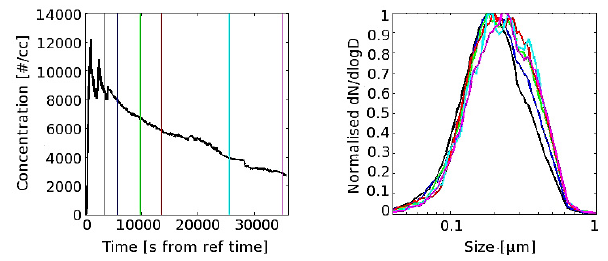
Table 1. ICIS-2007 sample